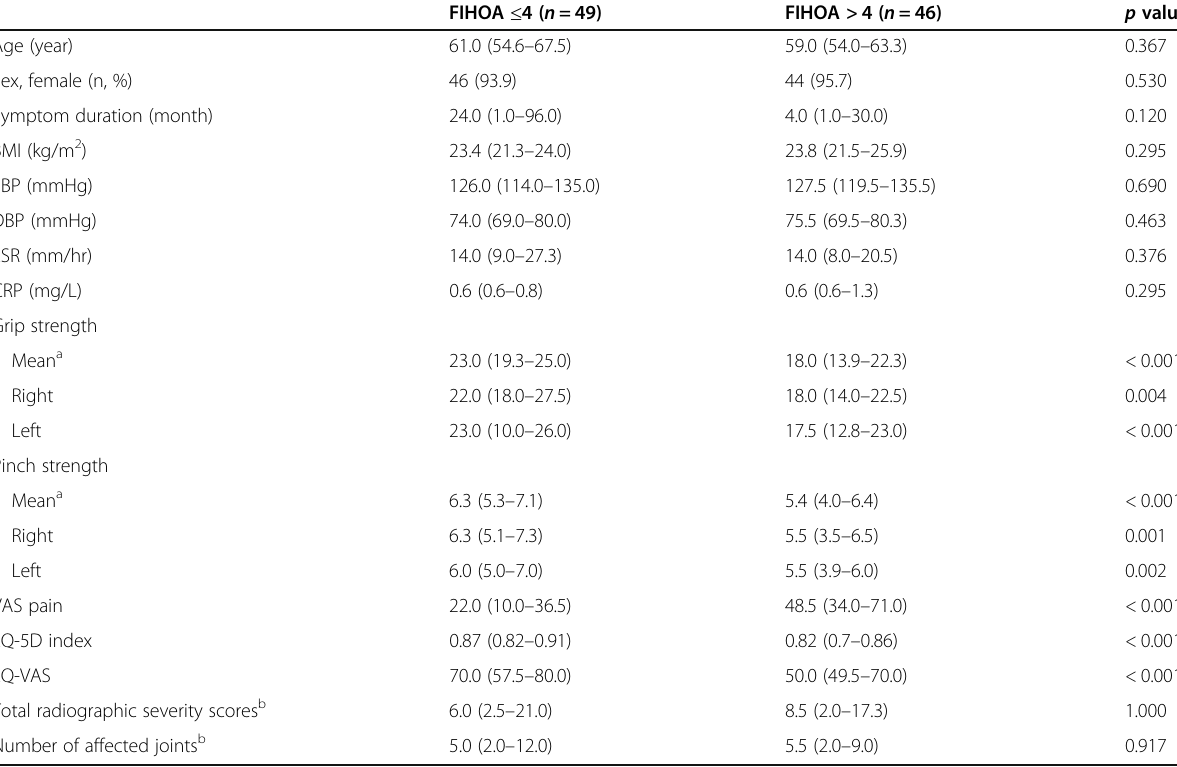
Table 2 Comparison of variables according to FIHOA